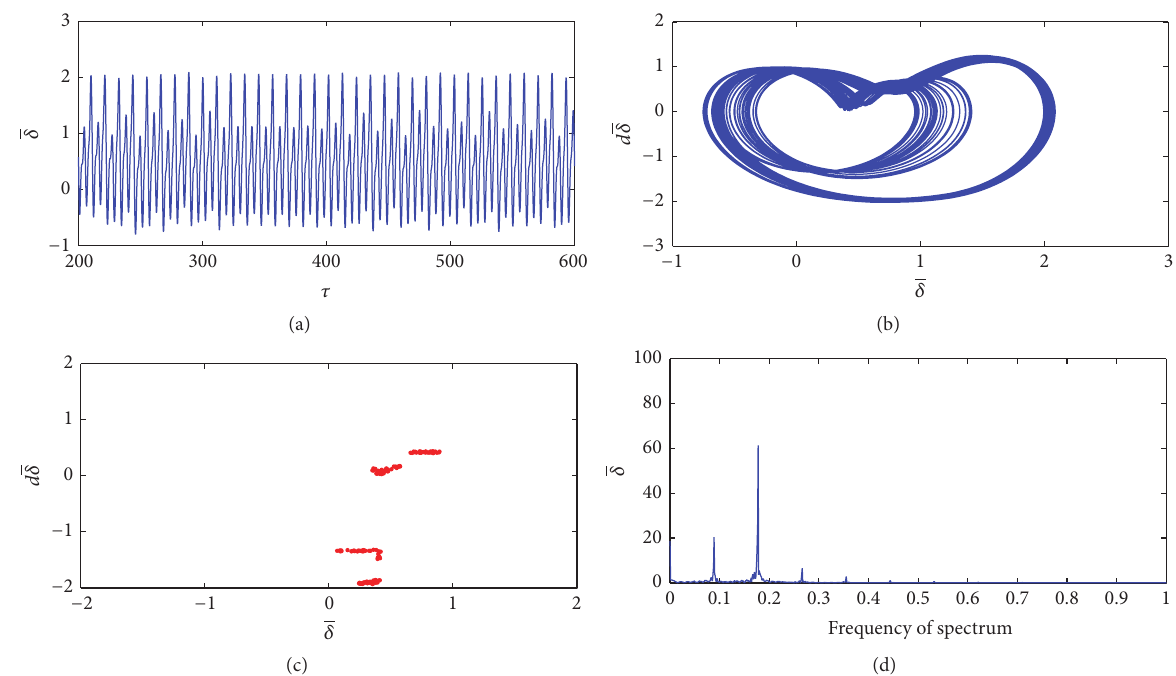
Figure 15: 𝑏 = 120 𝜇 m: (a) time history; (b) phase plane; (c) Poincar´e map; (d) Fourier